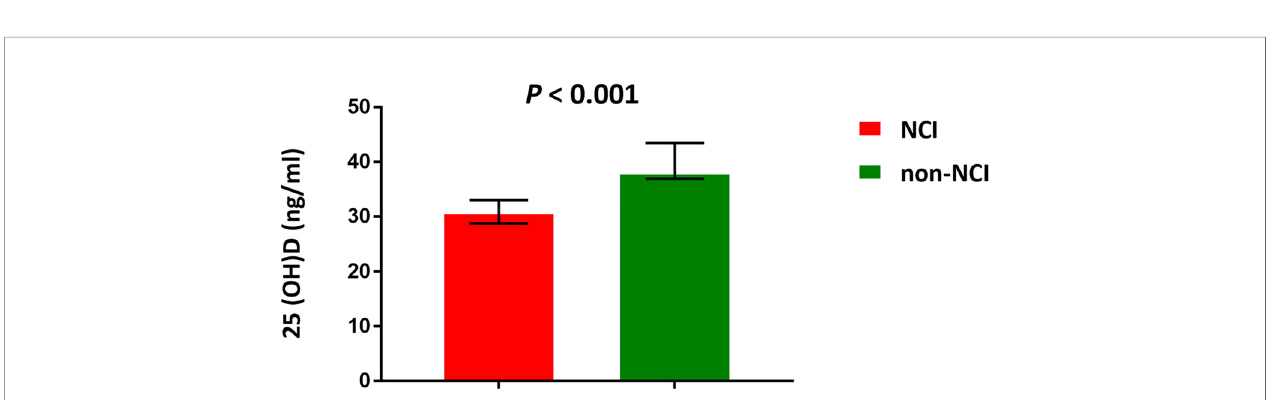
FIGURE 5 | Median concentrations of plasma 25(OH)D. NCI group, HIV-infected persons with neurocognitive impairment; non-NCI, HIV-infected persons without neurocognitive impairment. The error bars represent interquartile range.